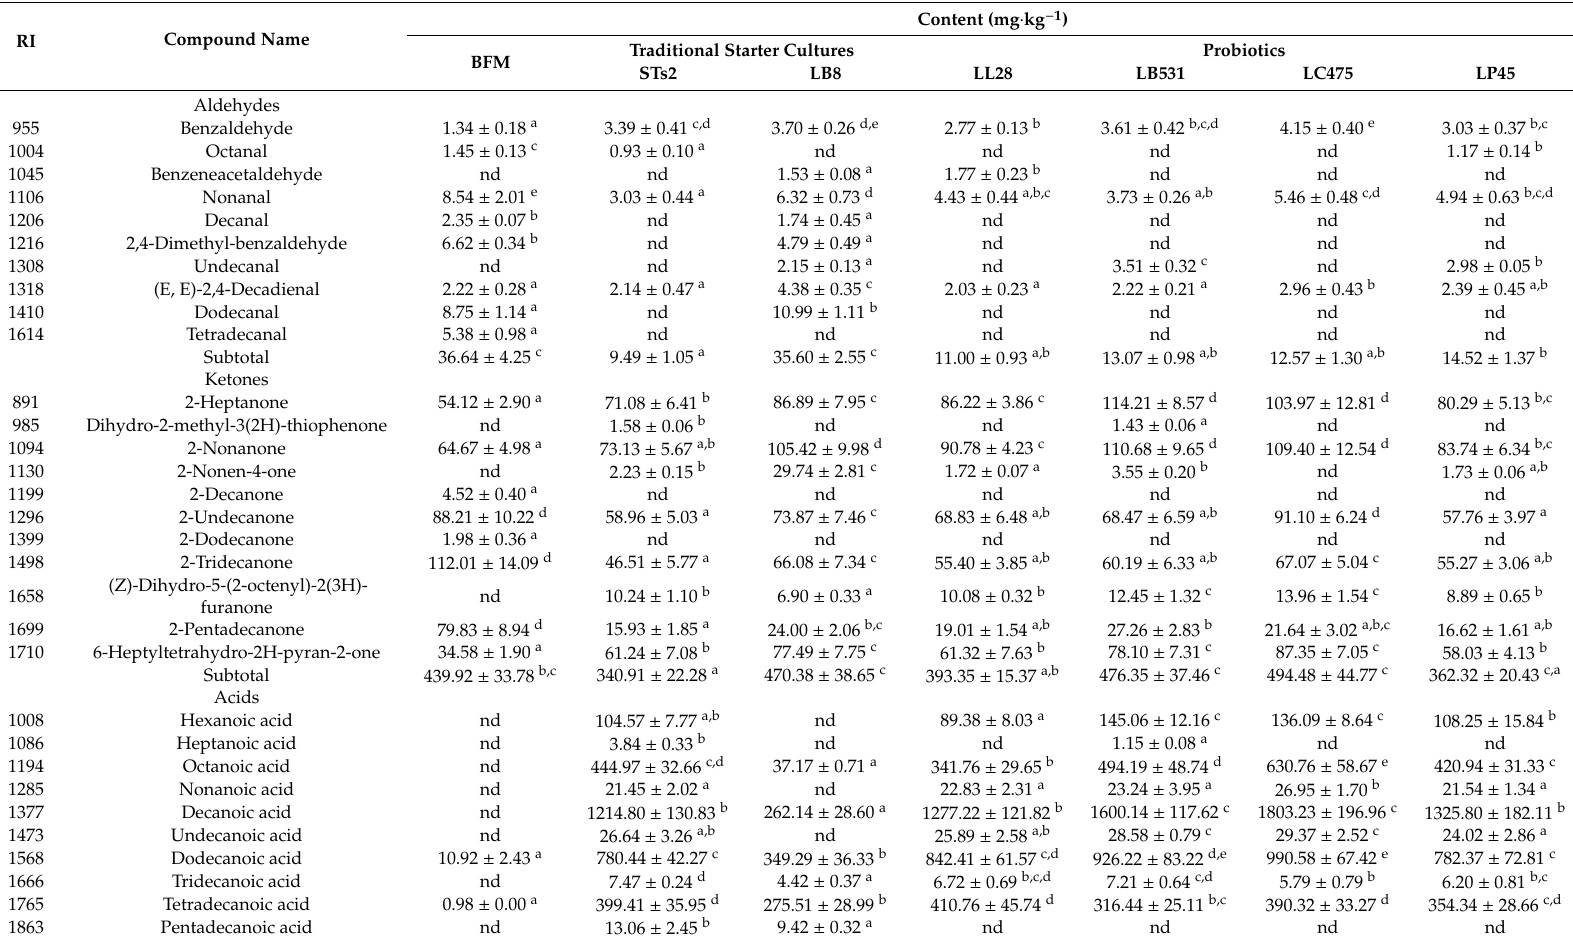
Table 1. Content of volatile compounds in the milks fermented with di ff erent starter cultures (n = 3).